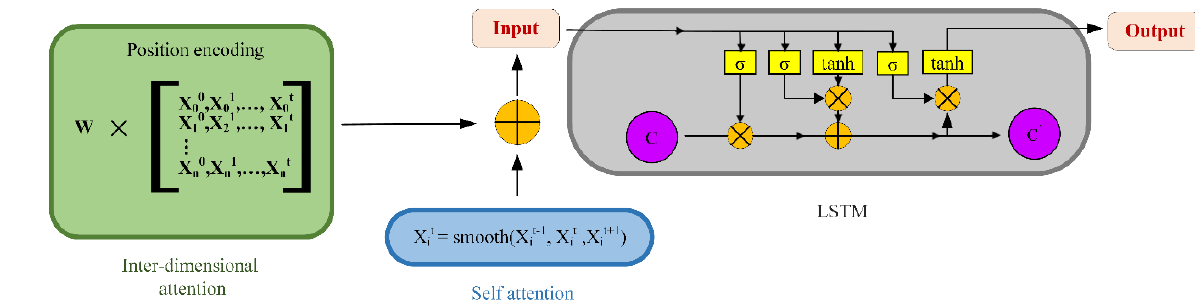
Figure 2. Structural diagram of the attention-based LSTM model.